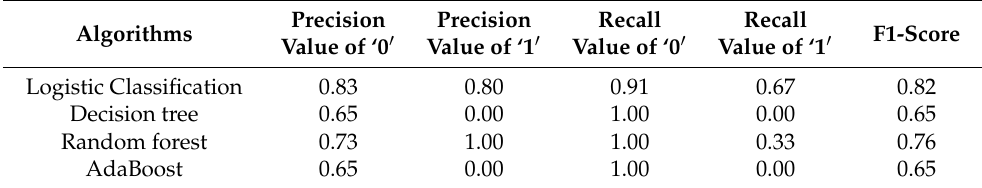
Table 2. Results obtained from supervised machine learning classification-based